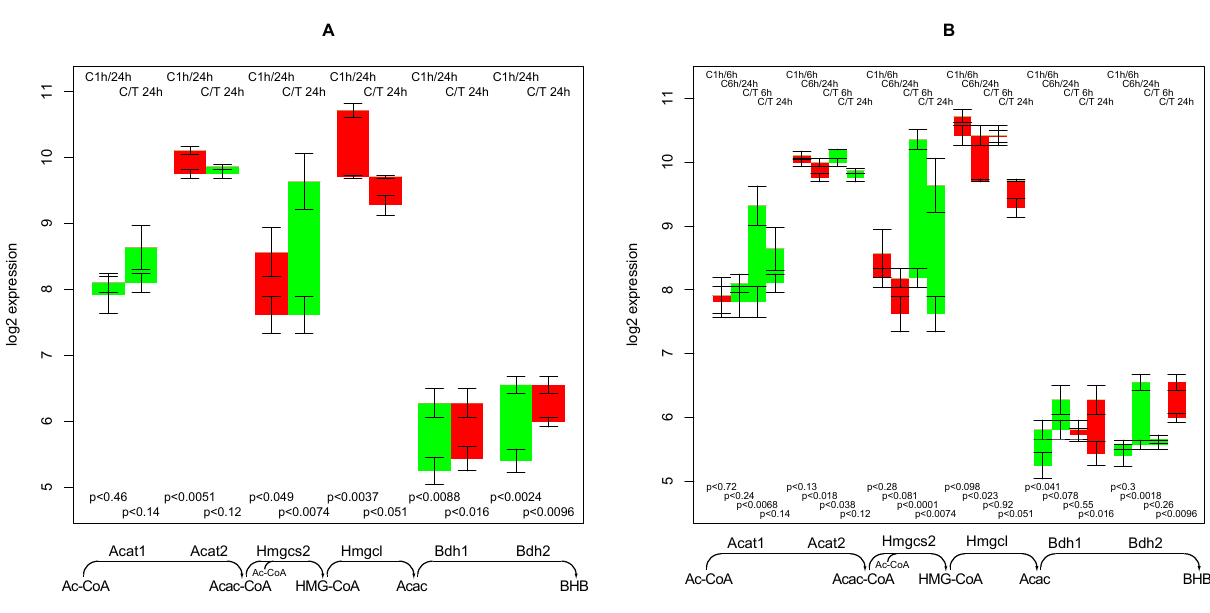
Figure 7. Regulation of genes involved in synthesis of β -hydroxybutyrate. Panel A shows comparisons of the 1 h and 24 h time points only, panel B shows comparisons involving the 6 h time point.